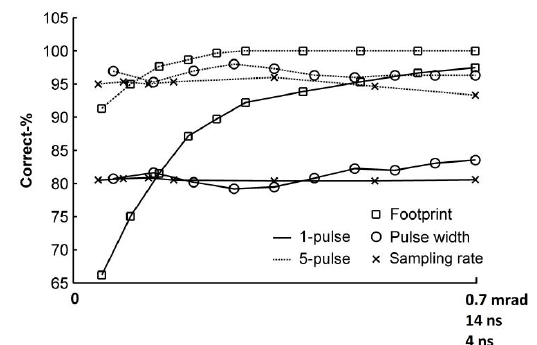
Figure 6. Effects of sensor parameters on the overall classifi- cation accuracy in simulated birch, raspberry and fireweed vegetation. The x axis is linear and the range from zero to the maximal values is